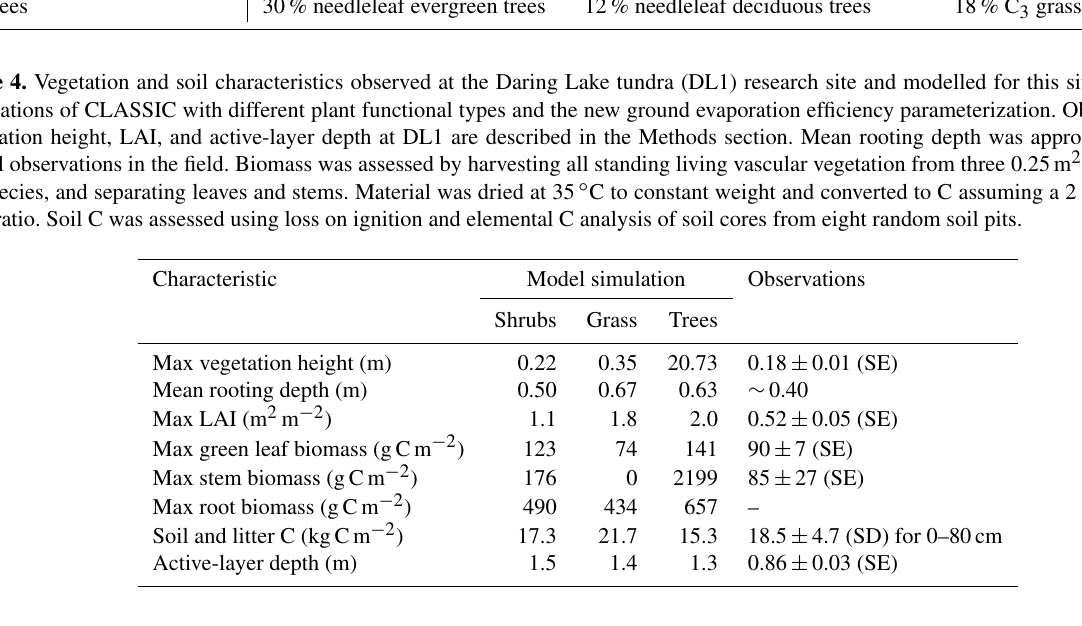
Table 3. Coverage of plant functional types (PFTs) used in the simulations. Simulation Shrubs (original and new β )